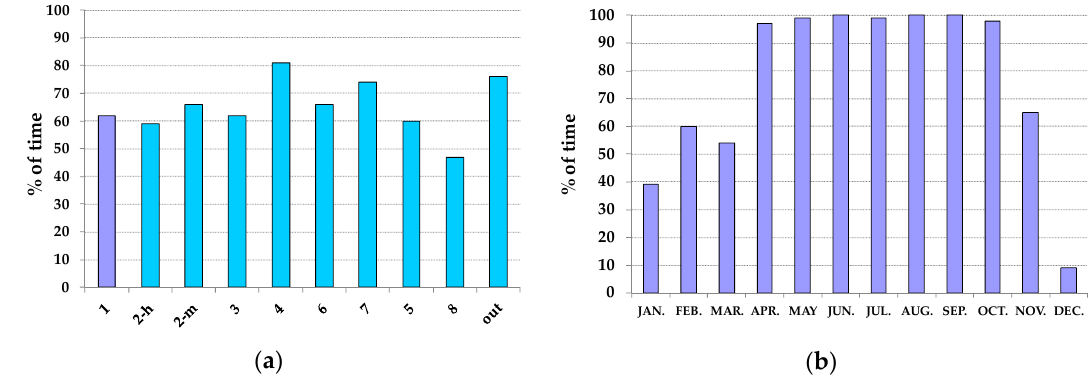
Figure 9. ( a ) Percentage of total time when RH was higher than 40%; ( b ) Percentage of monthly time when RH was higher than 40% at the monitoring point 1.